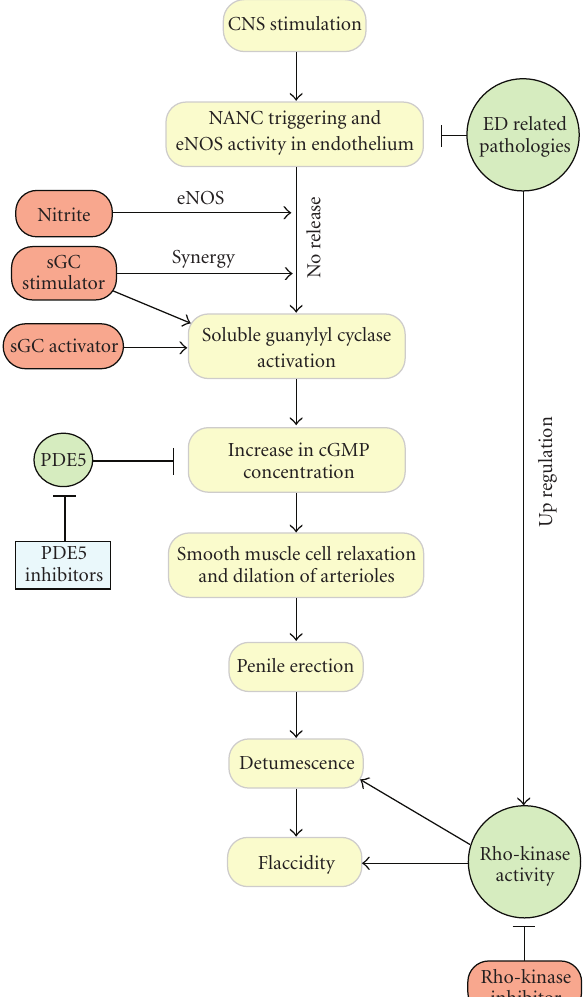
Figure 1: Pathway for the control of penile erection and detumescence. Stimulation of erection originates in the higher centers of the brain that result in upregulation of NANC and cholinergic activity and withdrawal of sympathetic activity in the nerves innervating the corpora cavernosa and small arteries of the penis. This increase in NANC and cholinergic activity results in upregulated NO release from the endothelium and NANC nerve terminals. The NO di ff uses into the smooth muscle of the corpora cavernosa and small arteries/arterioles of the penis and binds to the reduced heme iron of soluble guanylate cyclase, activating the enzyme and increasing the formation of cGMP from GTP. cGMP-dependent protein kinase activity opens potassium channels in smooth muscle cells and increases the uptake of calcium into stores. This leads to a decrease in intracellular calcium concentration and smooth muscle cell relaxation. This increases blood flow into the corporal sinuses and the cavernosal sinuses expand trapping blood in the corpora producing a penile erection. Detumescence is initiated by release of vasoconstrictors from sympathetic terminals and endothelium. A cGMP specific phosphodiesterase (type 5) breaks down the cGMP to GTP and terminates the actions of cGMP. Three new pharmacologic targets for the treatment of erectile dysfunction (sGC stimulators/activators, Rho-kinase inhibitors and sodium nitrite) have been identified and may be e ff ective in patients refractory to phosphodiesterase 5 inhibitor treatment. Recent experiments have shown that nitrite is capable of generating bioactive NO in the corpora cavernosa. Soluble guanylate cyclase stimulators (YC-1, A-350619, CFM-1571, and the Bayer compounds BAY 41-2272, BAY 41-8543, and BAY 63-2521) have been shown to act directly on the sGC enzyme and synergize with available NO which could be beneficial in disease states with low NO production and bioavailability. sGC activators (BAY 58-2667, BAY 60-2770 and HMR 1766/S3448) have also been shown to act on oxidized and heme-deficient sGC. Rho-kinase/RhoA activation has been shown to mediate detumescence and maintain flaccidity. Rho kinase inhibits the regulatory subunit of myosin phosphatase within smooth muscle cells and maintains contractile tone under low-cytosolic calcium concentrations. Upregulated Rho-kinase activity has been reported in ED, so Rho-kinase inhibitors (Y-27632 and SAR 407899) have potent erectile e ff ects and o ff er another therapeutic target for the treatment of